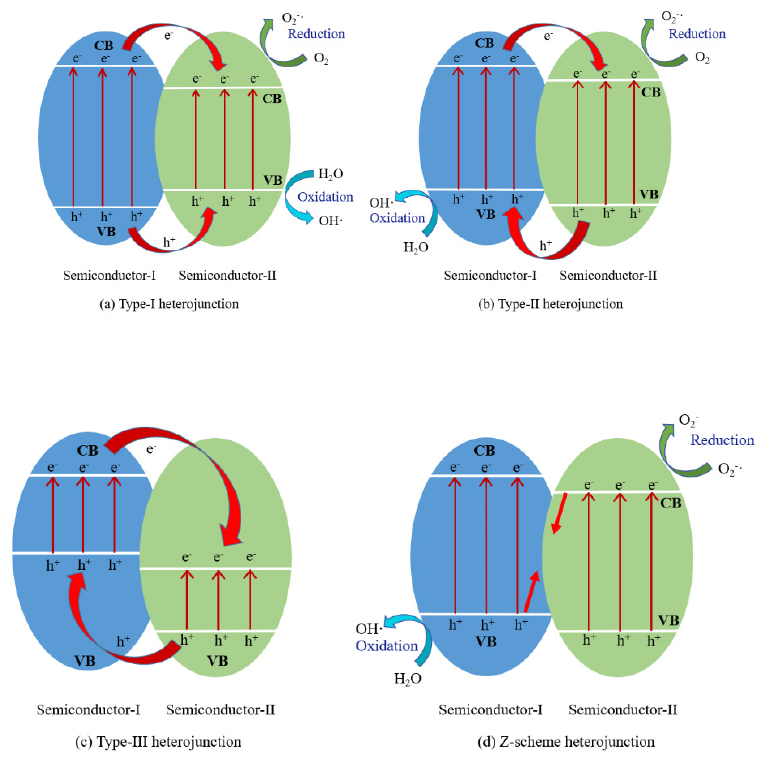
Figure 5. The band arrangement and electron migration mechanism of different heterojunctions. ( a ) Type-I heterojunction; ( b ) Type-II heterojunction; ( c ) Type-III heterojunction; ( d ) Z-scheme heterojunction.